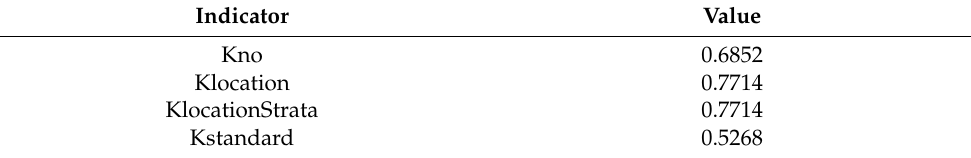
Table 4. Kappa Index values for the proposed 2017 validation model. Source: Authors’